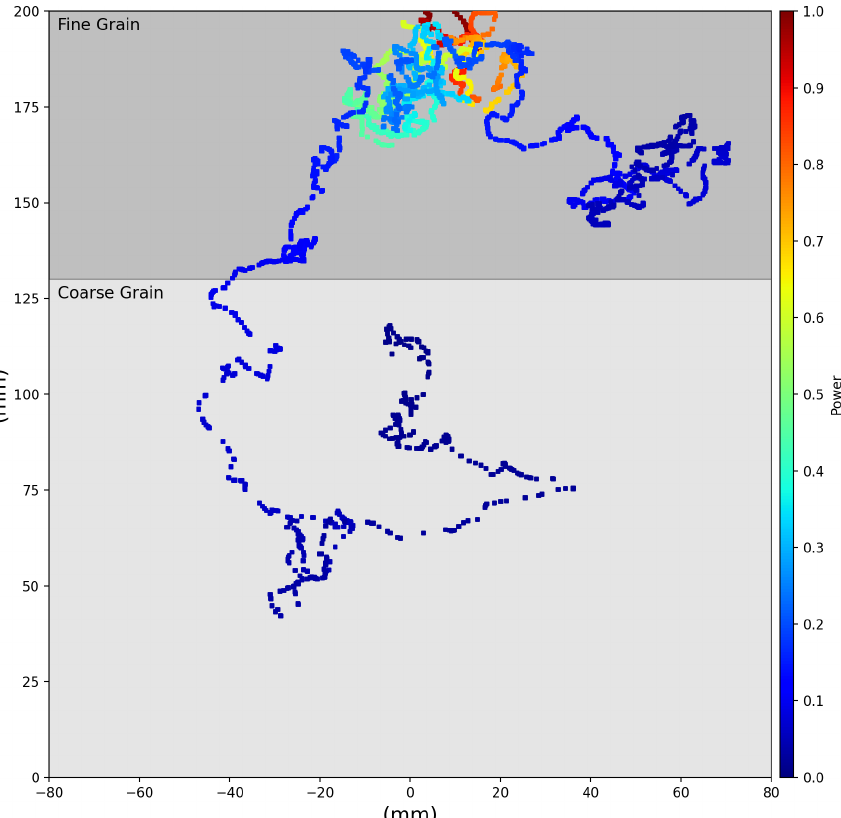
Figure 3. x/z cross section of two photons within a multi-layered snowpack 20cm deep. The color scale indicates the fractional energy of the photon packet. The background shading indicates the layers of the